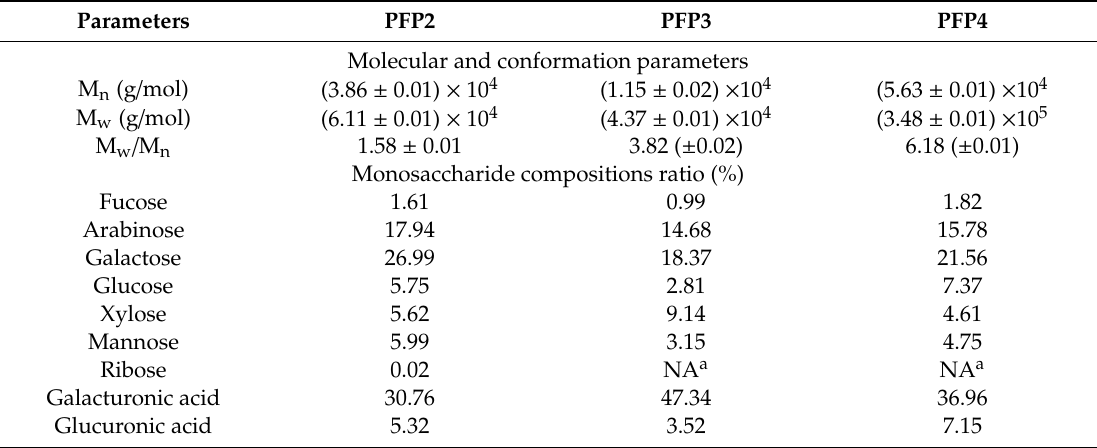
Table 1. Molecular, conformation parameters and monosaccharide compositions (%) of PFP2, PFP3, and